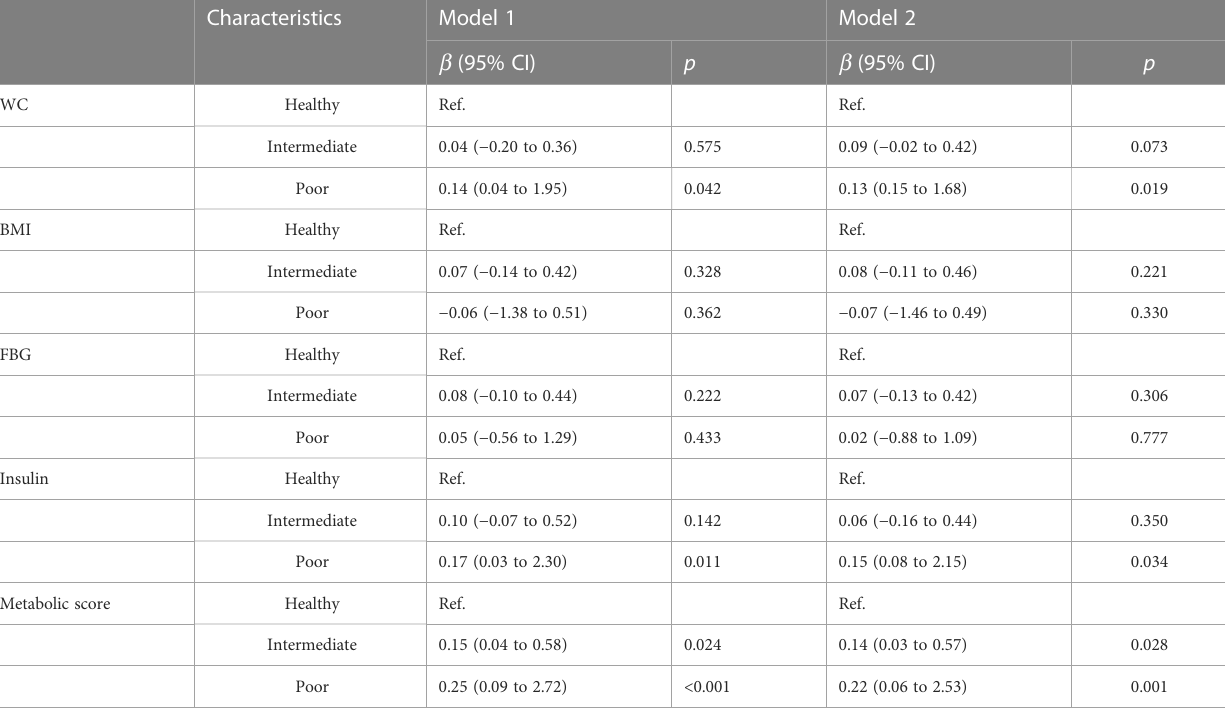
TABLE 3 Association from multivariate linear regression model between sleep pattern and metabolic parameters at 2-year follow-up.